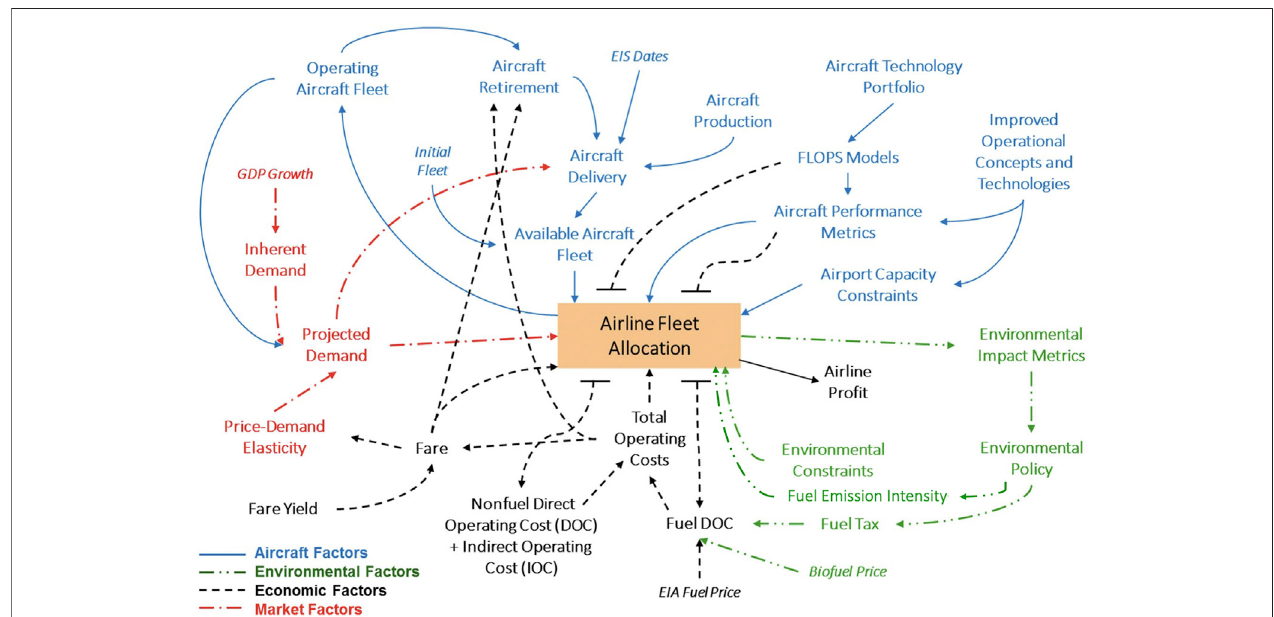
FIGURE 5 | System-dynamics-inspired representation of FLEET [adapted with permission from (Moolchandani et al., 2017)].